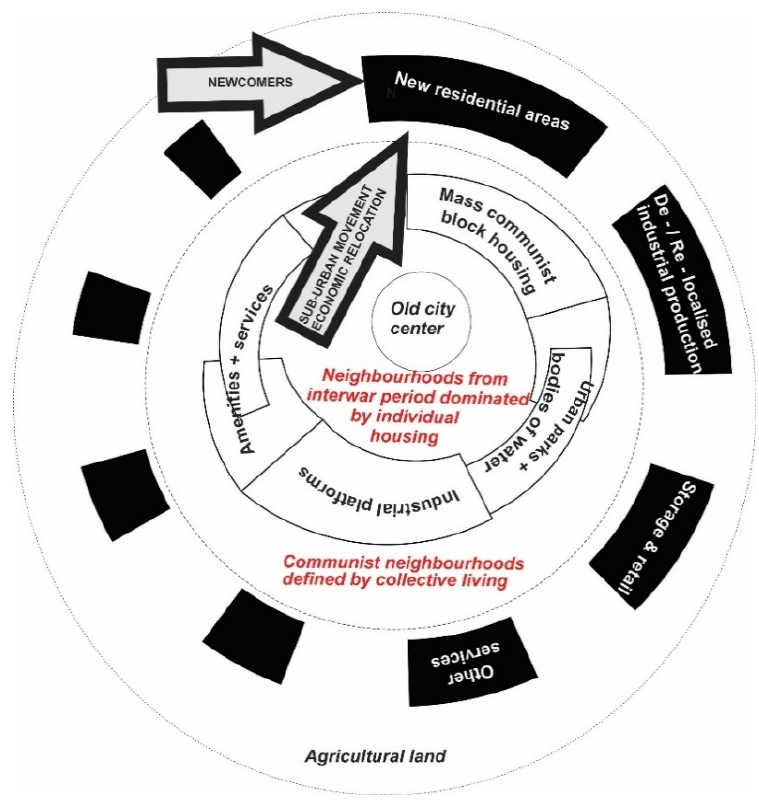
Figure 1. Conceptual framework of Bucharest’s urban structure and dynamics.